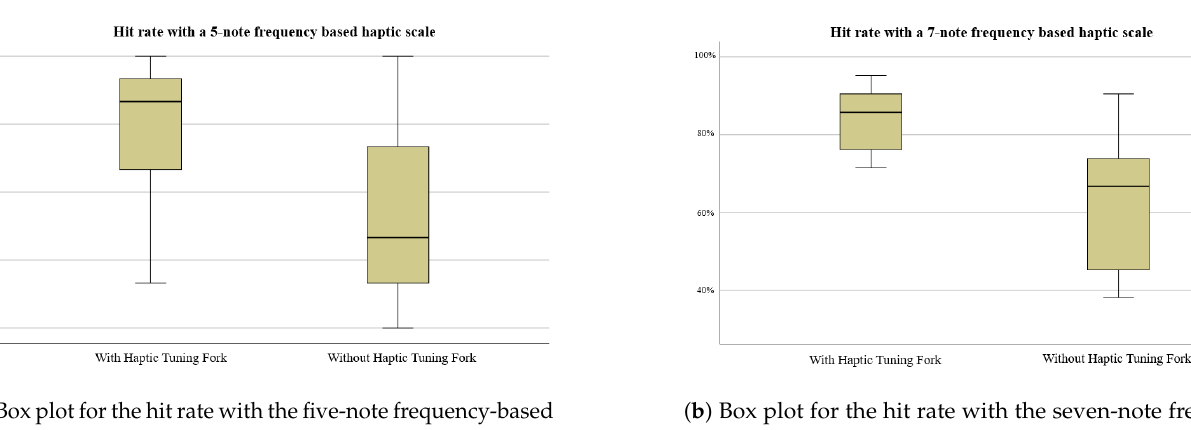
( b ) Box plot for the hit rate with the seven-note frequency- based haptic scale. Mean difference 22.08% ( p -value < 0.001). Figure 3. Hit rate results for Experiment